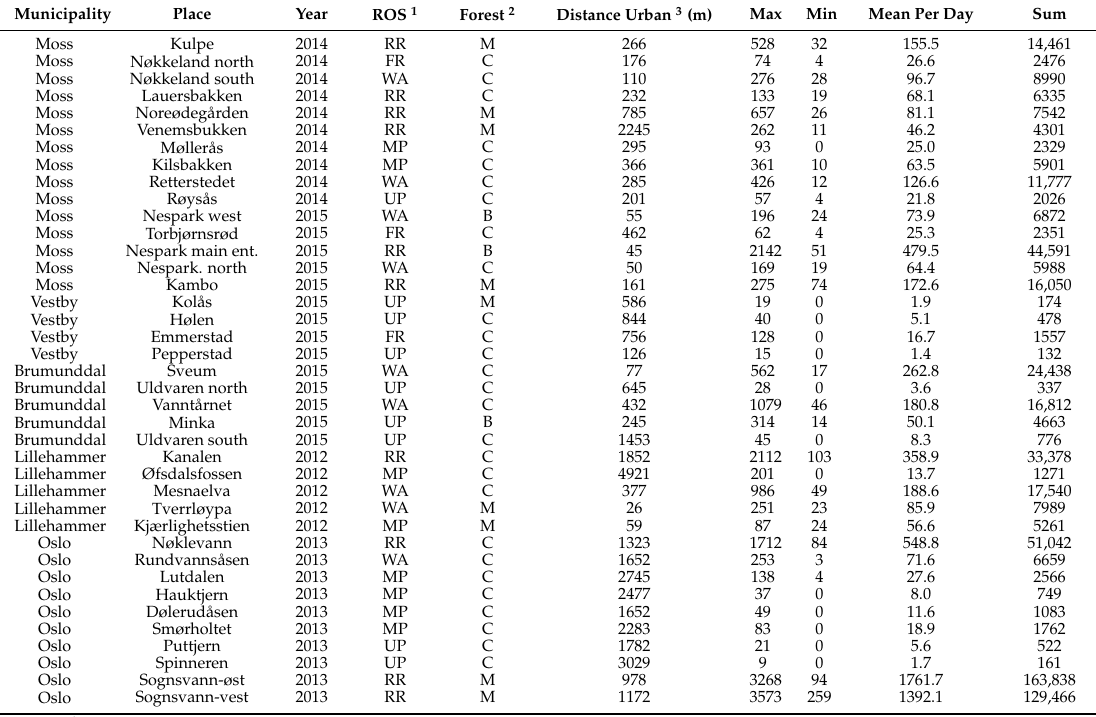
Table 4. Key information for recreational infrastructure sites where automatic counting have taken place in urban forests in southeastern Norway and the actual use of these infrastructure expressed by max, min, mean per day and sum during the period of 1 July to 1 October in the municipalities of Moss, Vestby, Brumunddal, Lillehammer and